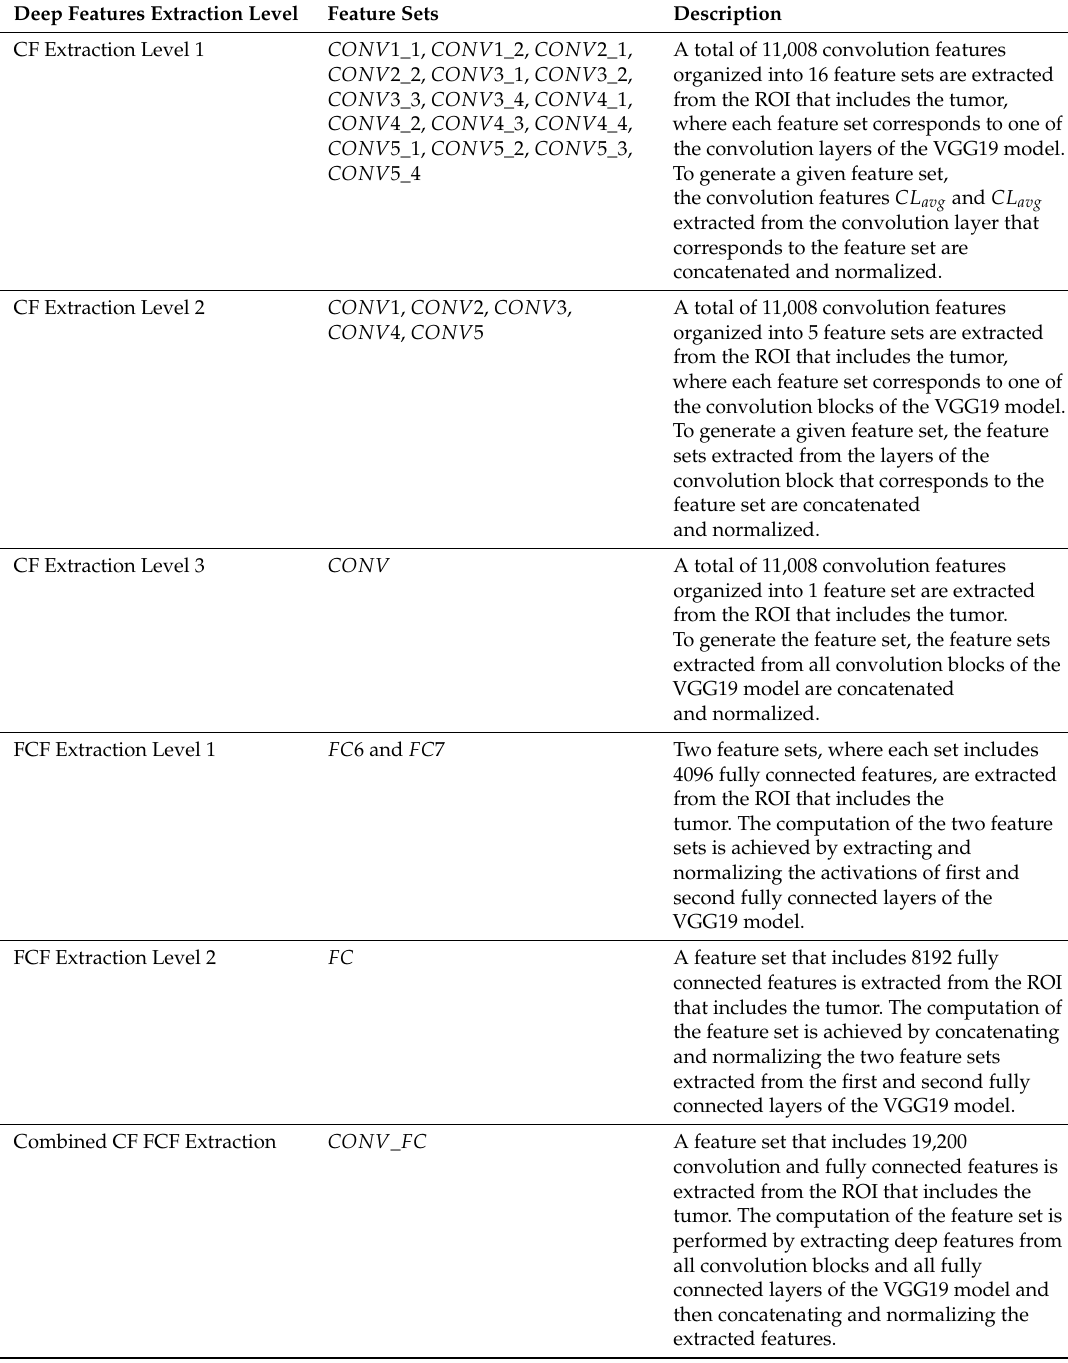
Table 1. The six levels that are employed to extract the deep feature sets from the BUS